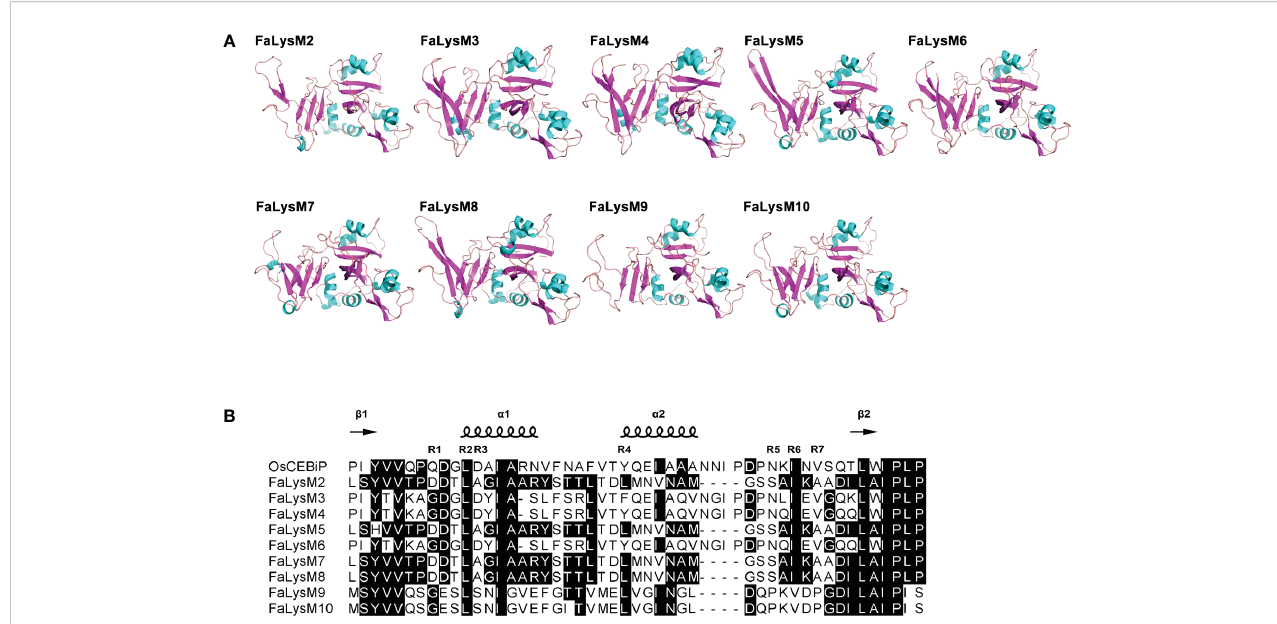
FIGURE 1 Analysis of structural models of FaLysM proteins by Pymol. (A) The structural models of FaLysM proteins. Different colors represent different secondary structures (cyan:helix; magenta: beta-sheet; pink: loop). (B) Sequence alignment of conserved mode of NAG recognition by LysM proteins between OsCEBiP (LysM2 domain, amino acids 111-161) and FaLysMs. R1-R7 indicate the conserved position in the secondary structures. Consensus and similar amino acid residues for all sequences are shown in solid black